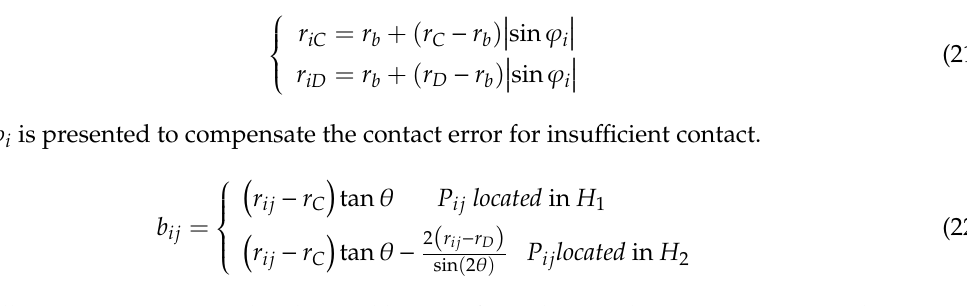
Figure 8. The model of equal division for meshing deformation. Approximately, the k th tiny arc of meshing tooth profile can be presumed as the length of